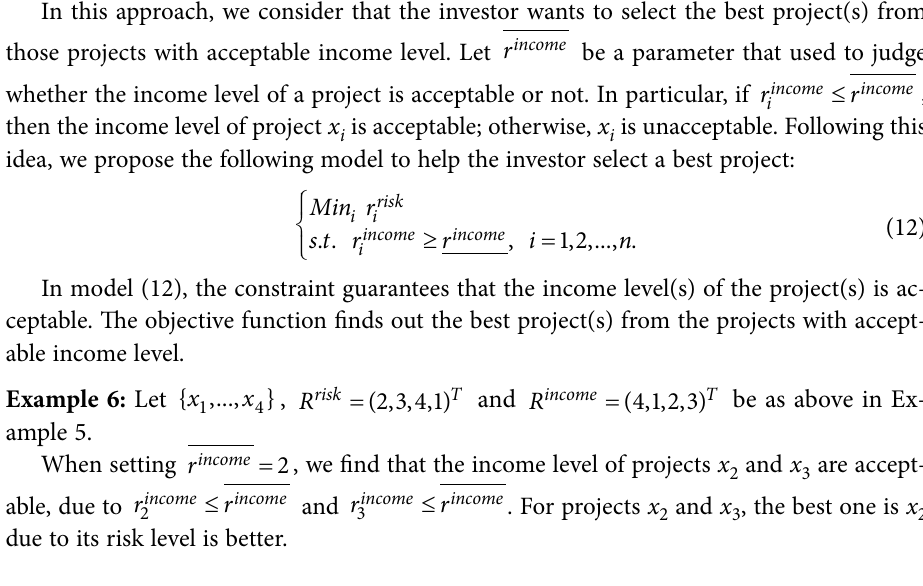
Table 1. The risk criteria